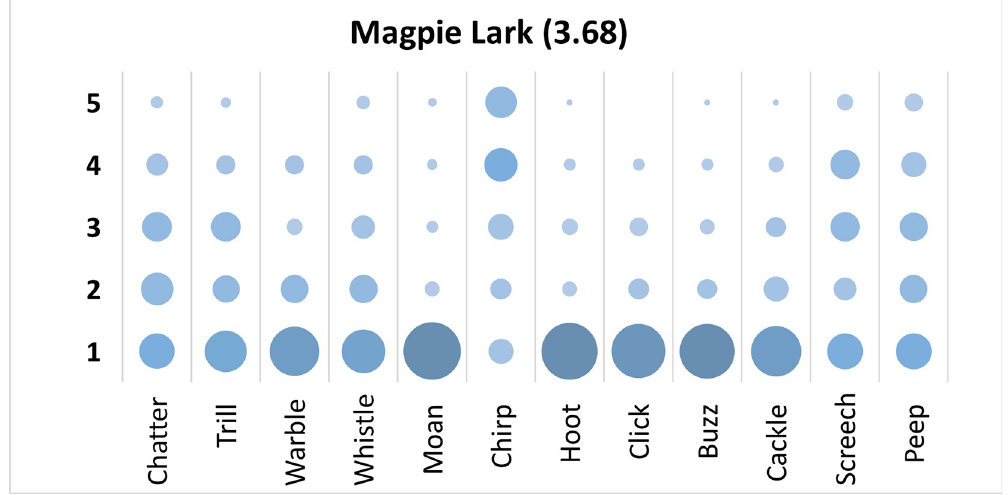
Fig 6. Count of participants’ sound descriptions scores for the Magpie Lark with confidence ratings in brackets.